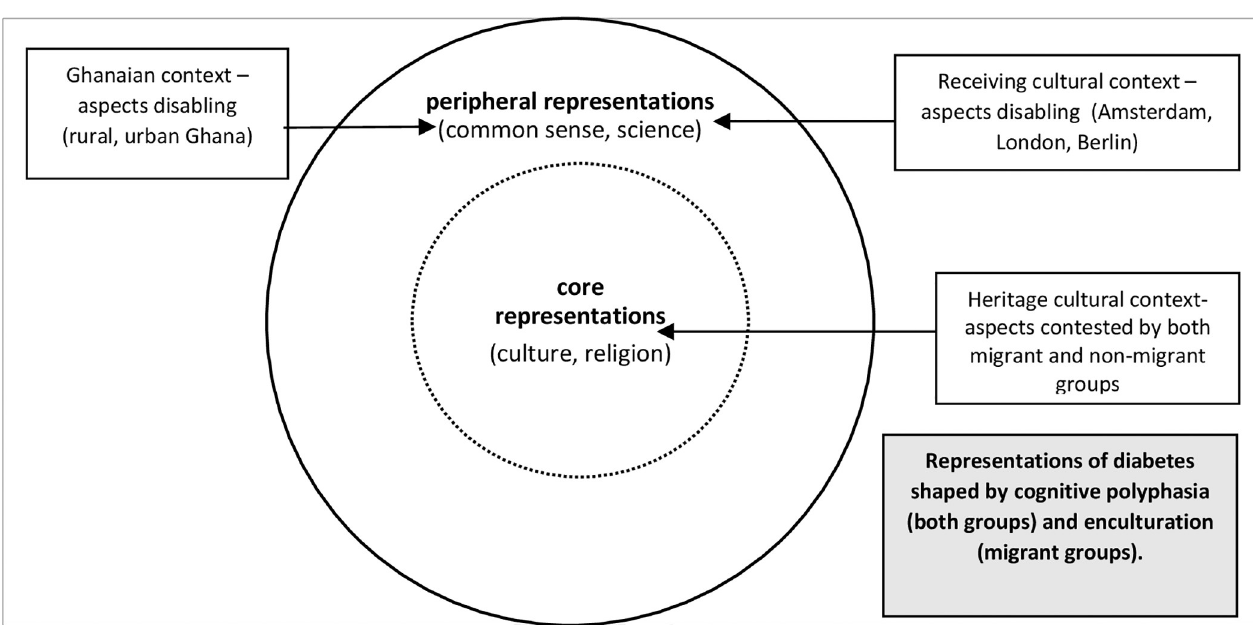
Fig 1. Core and peripheral representations of T2D among Ghanaian migrants in Europe and Ghanaians in Ghana.